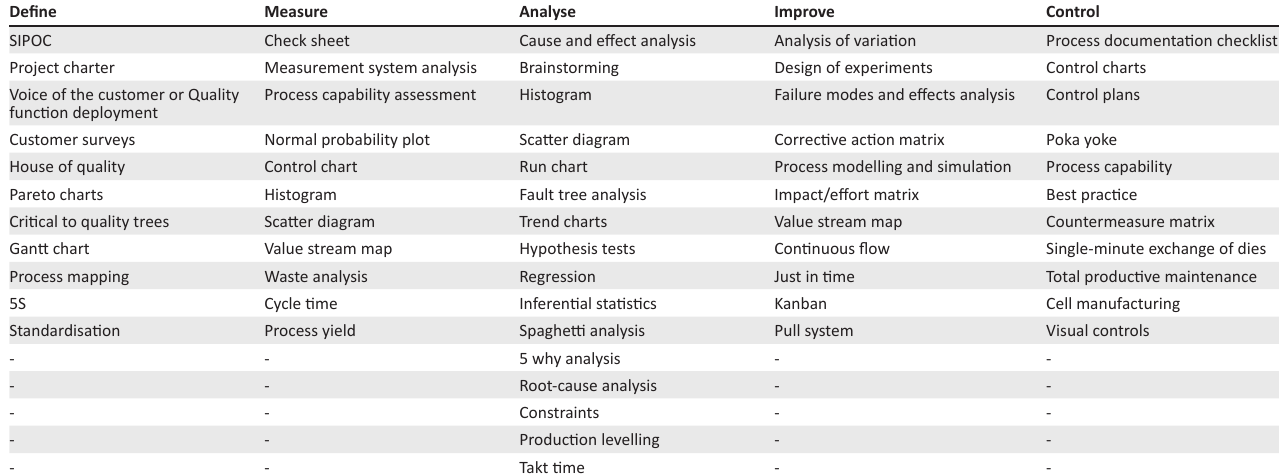
TABLE 9: Lean Six Sigma problem-solving tools. Define